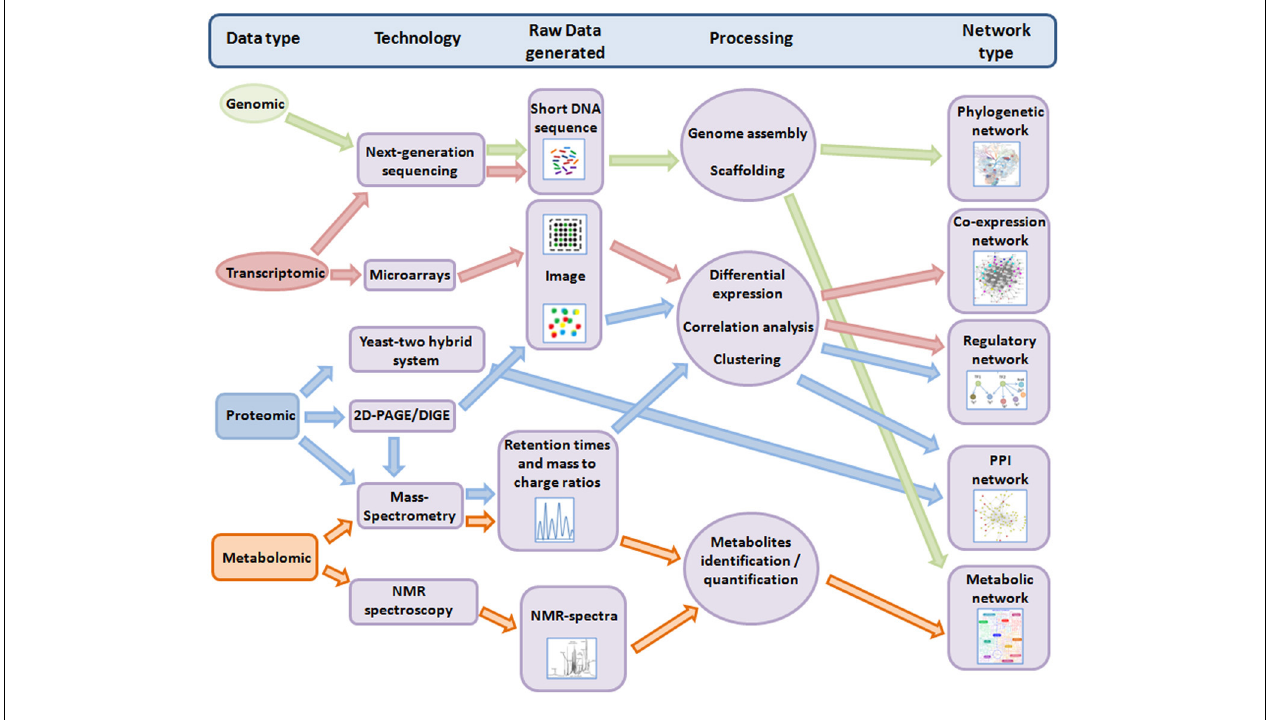
FIGURE 1 | Overview of the workflow from different “omic” methods to different systems-level networks. Only technologies discussed in this review are shown. For more details, the manually-curated meta-database OMICtools (http://omictools.com/)